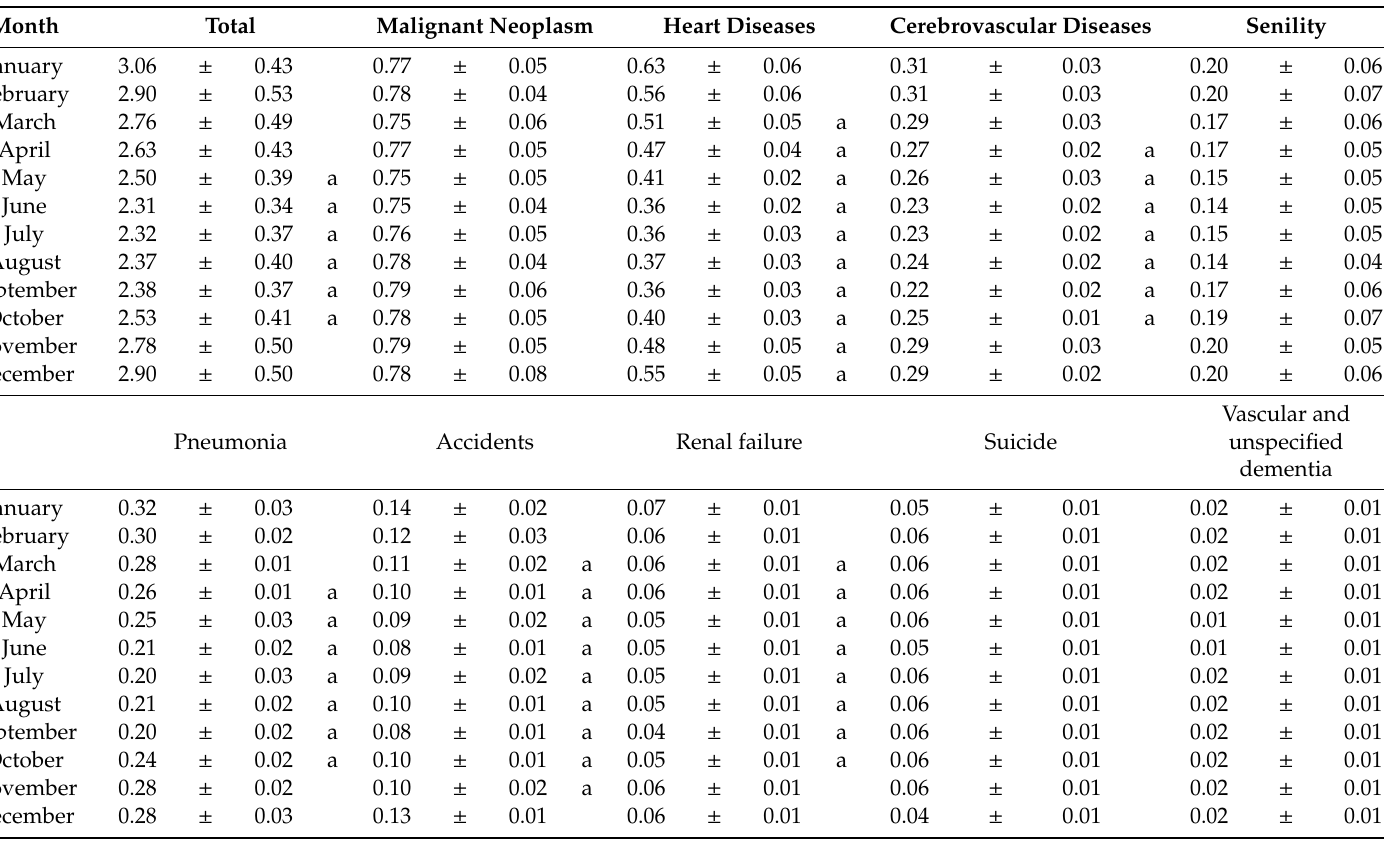
Table 3. Comparison of the number of deaths per month in Gifu prefecture,